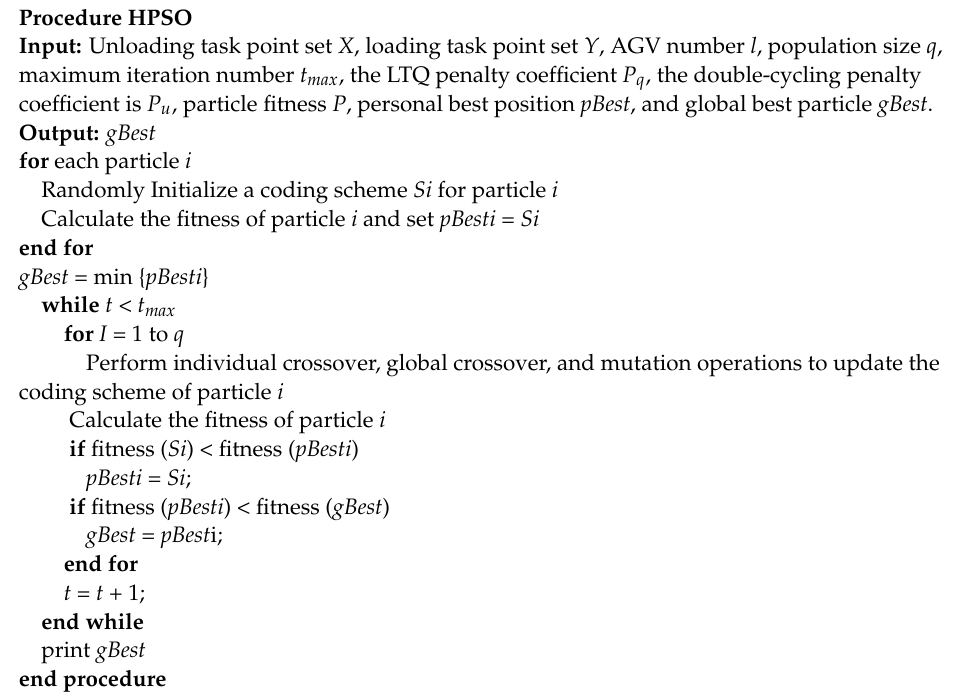
Algorithm 1 AGV double-cycling